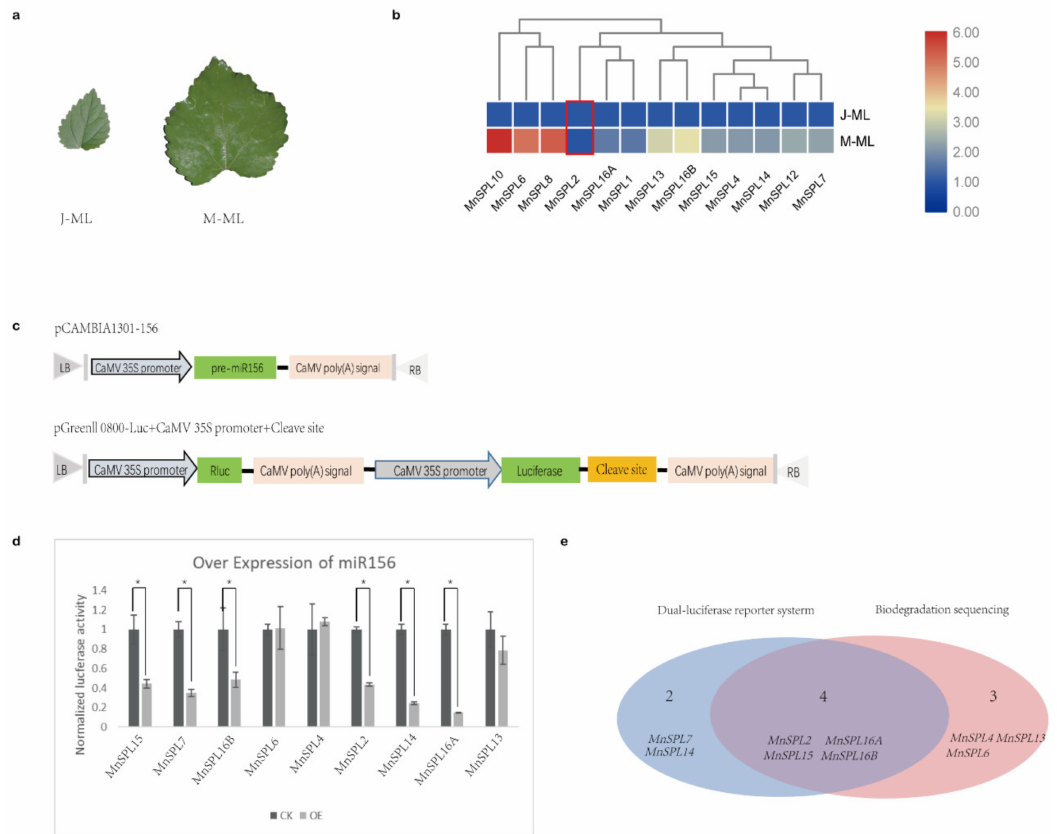
Figure 4. Identification of miR156 target genes in mulberry. ( a ) Morphological photos of mature leaves of juvenile (J-ML) and mature (M-ML) mulberry. ( b ) The expression trend of MnSPLs in mature leaves of juvenile (J-ML) and mature (M-ML) mulberry measured by RT-qPCR. Red boxes indicate there were no significant differences between this sample. Heatmap was drawn using TBtools, and the min–max normalization method was used to normalize the data. ( c ) Schematic of plasmids used in dual-luciferase assays. ( d ) The target genes of miR156 identified by dual-luciferase assays. CK: control check, empty pGreenII 0800-Luc vector and pCAMBIA-156; OE: reconstructed pGreenII 0800-Luc vector and pCAMBIA-156. Values represent the mean ± SD from three biological replicates and were statistically analyzed (independent-samples t -test): *, p < 0.05. ( e ) Venn diagrams showing miR156 target genes in